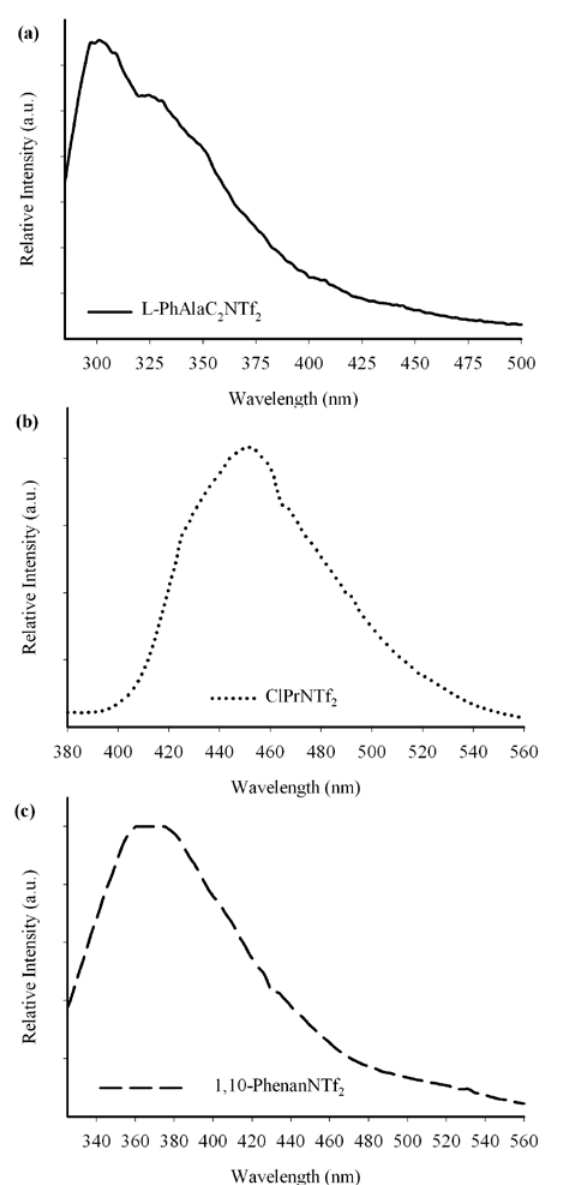
Figure 3. Fluorescence emission spectra of 10 μM (a) L-PhAlaC